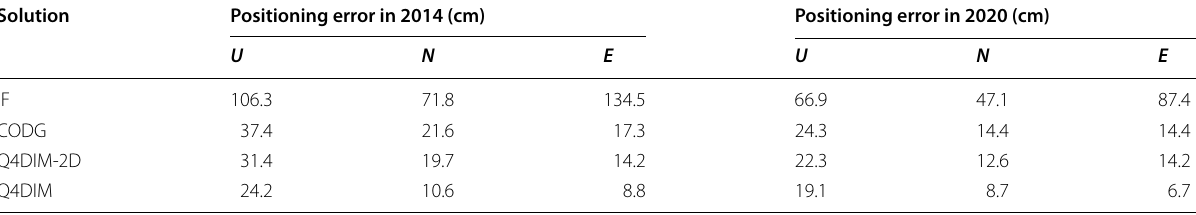
Table 4 SF‑PPP positioning error of RMS in Up( U ) / North( N ) / East ( E ) in 2014 and 2020 Solution Positioning error in 2014 (cm) Positioning error in 2020 (cm)